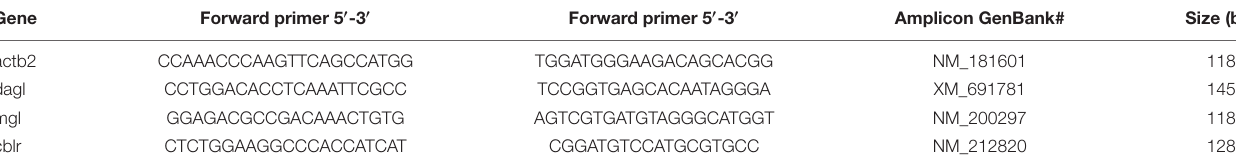
TABLE 1 | Primers used for qPCR analysis.